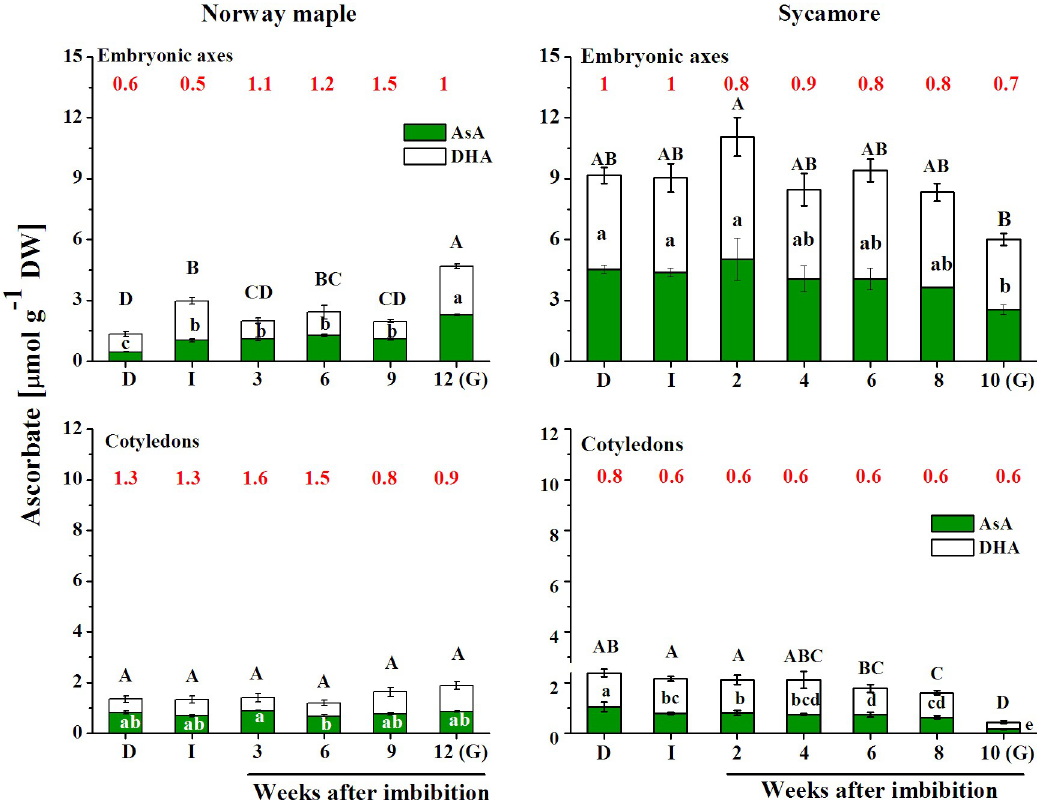
Fig 5. Changes in the levels of the reduced (AsA) and oxidized (DHA) forms of ascorbate and their ratio (red font) reported in the embryonic axes and cotyledons of dry and germinating Norway maple and sycamore seeds. (D) Dry seeds; (I) Imbibed seeds; (G) Germinated seeds. Data are the means of three independent replicates ± std. Statistically significant differences are indicated with different letters (one-way ANOVA, followed by Tukey’s test at p < 0.05). The capital letters refer to